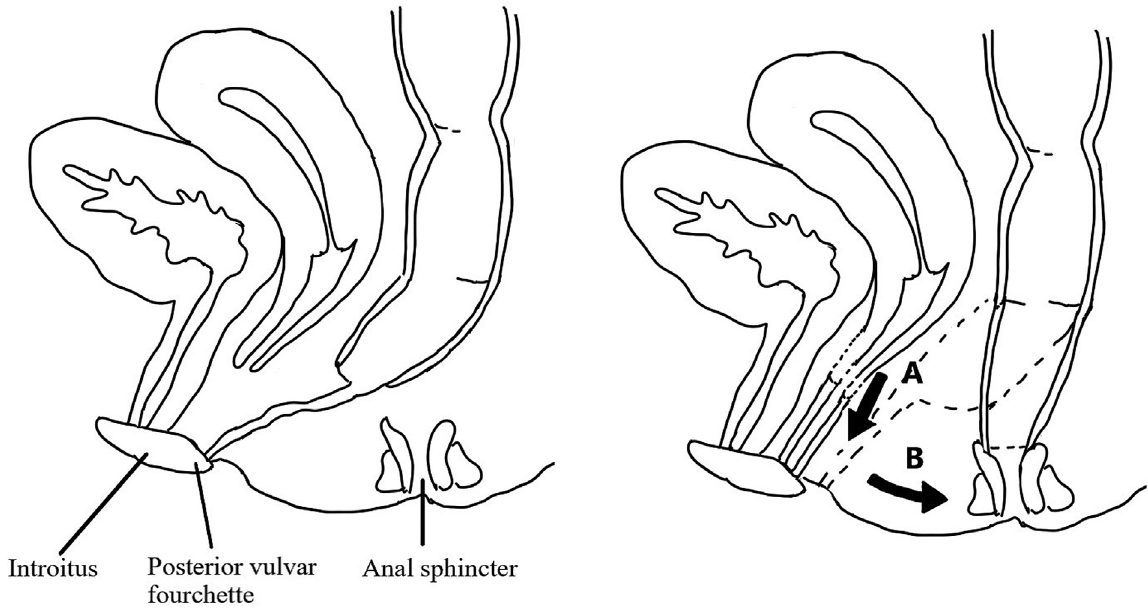
Fig.3 Dueto anintact right-sideduterus and vagina, the vagina canbe mobilized tothe introitusvia a pull-through( A ), whilethe distal rectum is mobilized and reinserted into the anal sphincter through a posterior sagittal anorectoplasty ( B ).